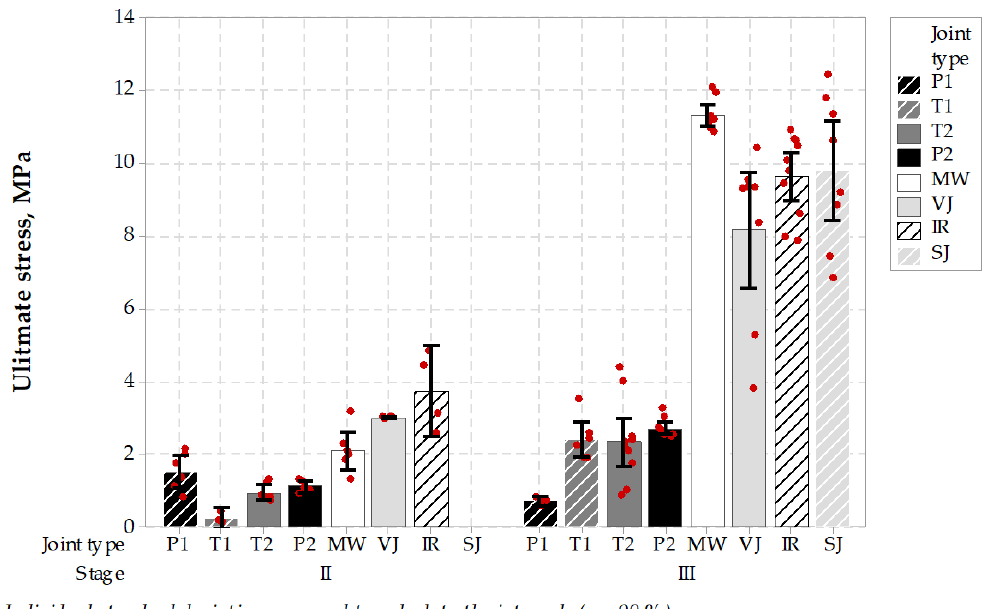
Figure 11. Semi-circular bending test results (the higher, the better).